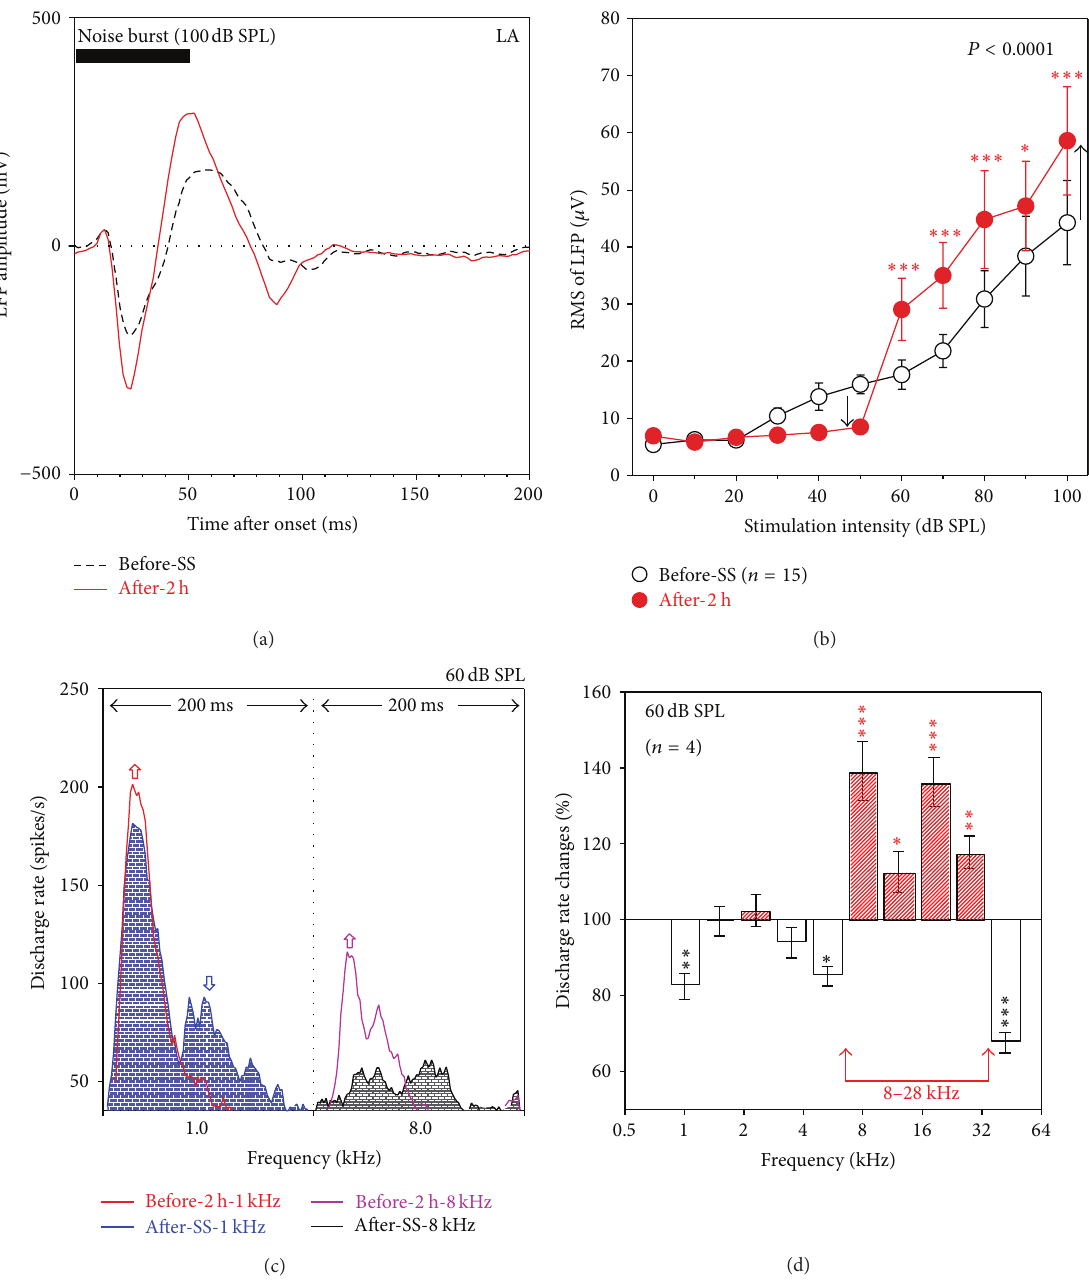
Figure 7: The effects of SS injection on auditory responses of the LA. (a) An example of LFP to noise burst at 100dB SPL (black) showing an increase after SS injection (red). (b) Mean RMSs of LFP ( 𝑛 = 15 ) in a time window of 100ms as a function of stimulation level, showing enhancement at high stimulation levels ≥ 60dB SPL but reduction at low-stimulation levels < 60 dB SPL. (c) Example of PSTHs in response to tones at 1.0kHz (left) and 8.0 kHz (right) before and after SS injection showing greater increase after SS injection at the high-frequency; (d) SS-induced changes (%) of mean discharge rate in a time window of 100ms showing SS-induced increase in the frequency range of 8–27.7 kHz. Stimulation: 50 ms noise or tone bursts; treatment: SS (250 mg/kg, i.p.). The vertical bars are SEs. ∗ 𝑃 < 0.05 , ∗∗ 𝑃 < 0.01 , and ∗∗∗ 𝑃 < 0.001